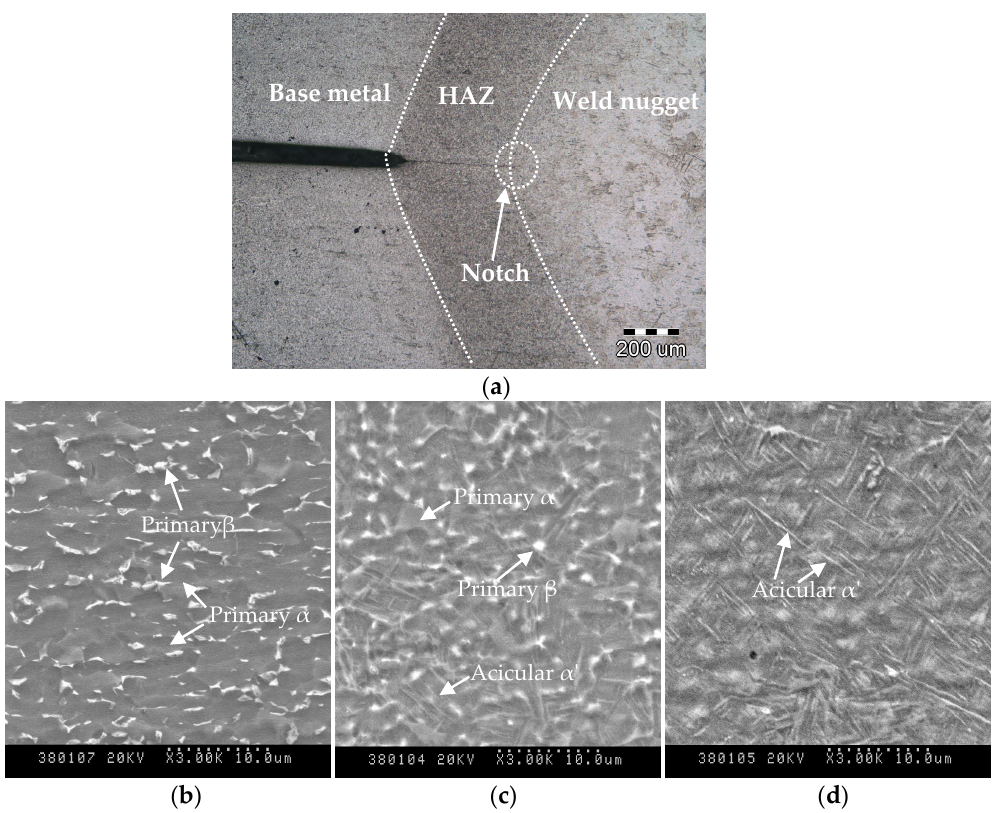
Figure 10. Microstructure of: ( a ) Three zones; ( b ) base metal; ( c ) HAZ; and ( d ) weld nugget zone.